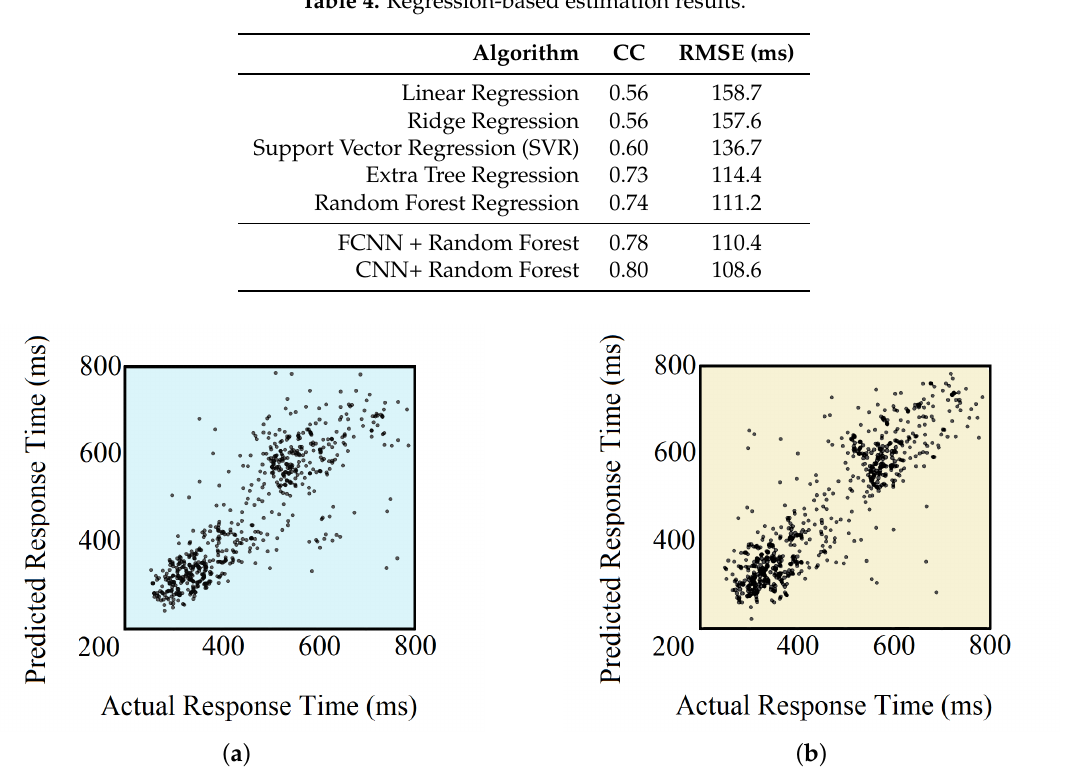
Table 4. Regression-based estimation results.